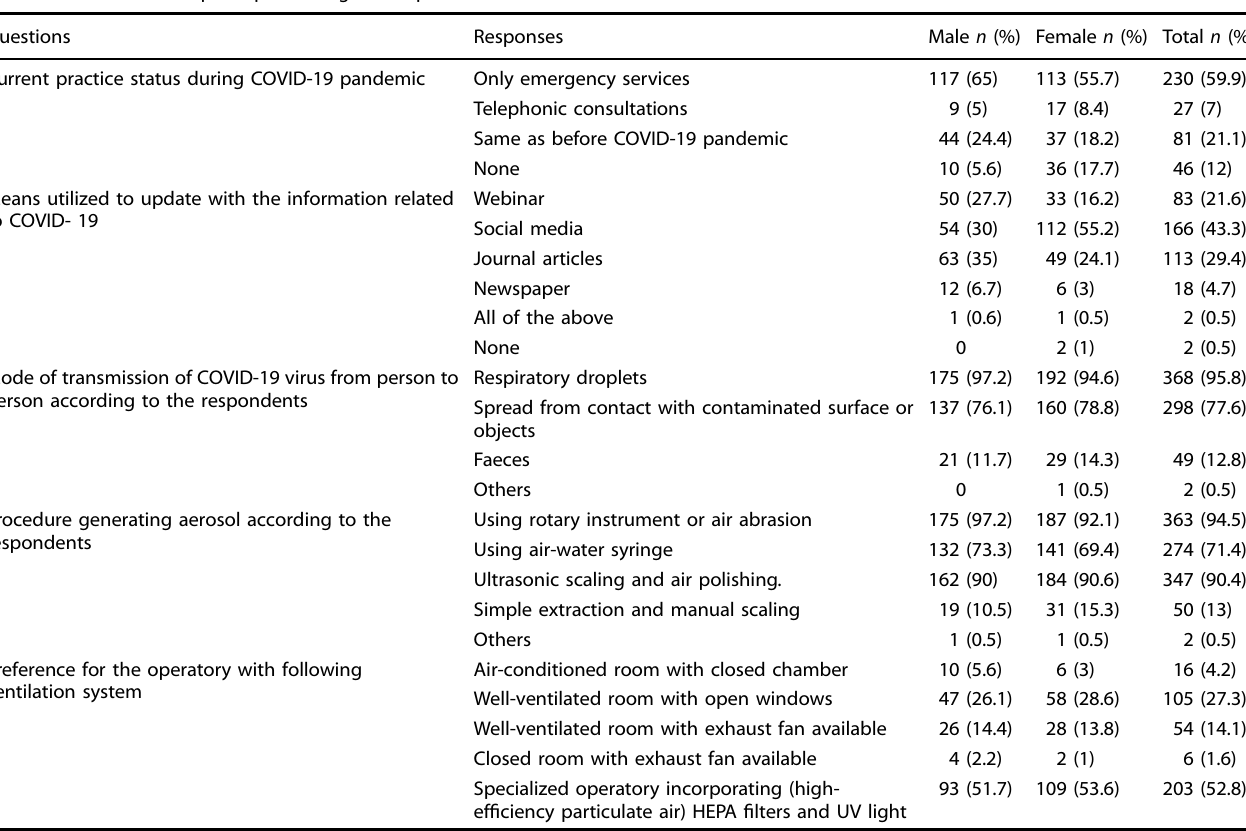
Table 2. Distribution of participants for general